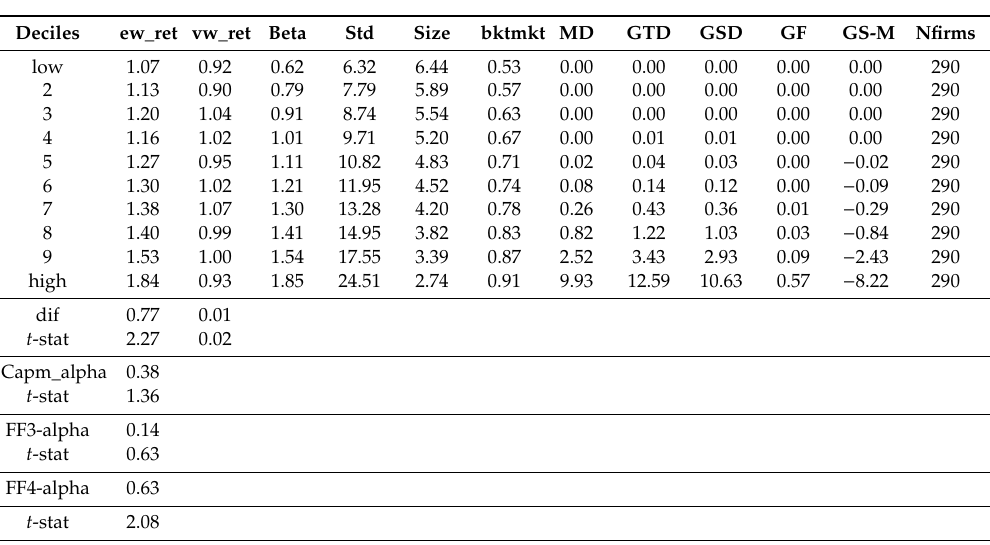
Table 4. Average returns from decile portfolios sorted by Geske’s short-term default probability. From the data for July 1963 to December 2013, at the end of each month, we used the most recently calculated Geske’s short-term default probability for each firm to sort all stocks into deciles. We then calculated the equally weighted and value-weighted returns over the next month. The returns are the average monthly returns over the sample period. Portfolio 1 is the portfolio with the lowest default risk and Portfolio 10 is the portfolio with the highest default risk. High-Low is the di ff erence between the high and low default risk portfolios. t -values are calculated from Newey-West standard errors. Alphas are calculated using the CAPM, the three-factor Fama-French, and the four-factor model (Fama-French three-factor plus momentum).